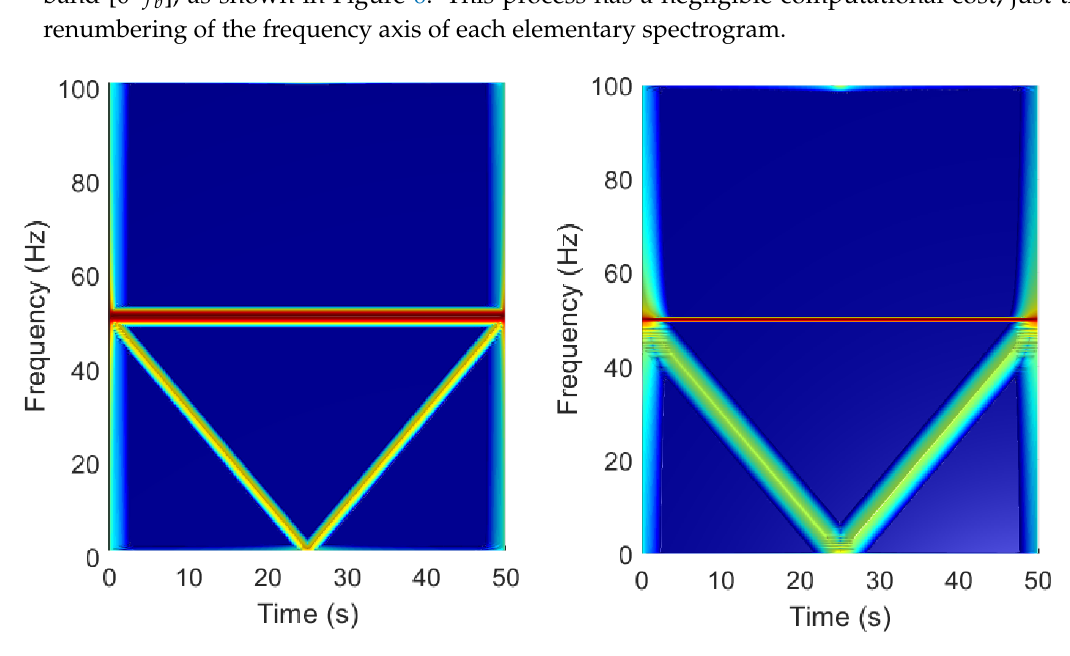
Figure 6. Relocation in the frequency axis of the elementary spectrograms, so that all of them span the same frequency band [0– f b ].